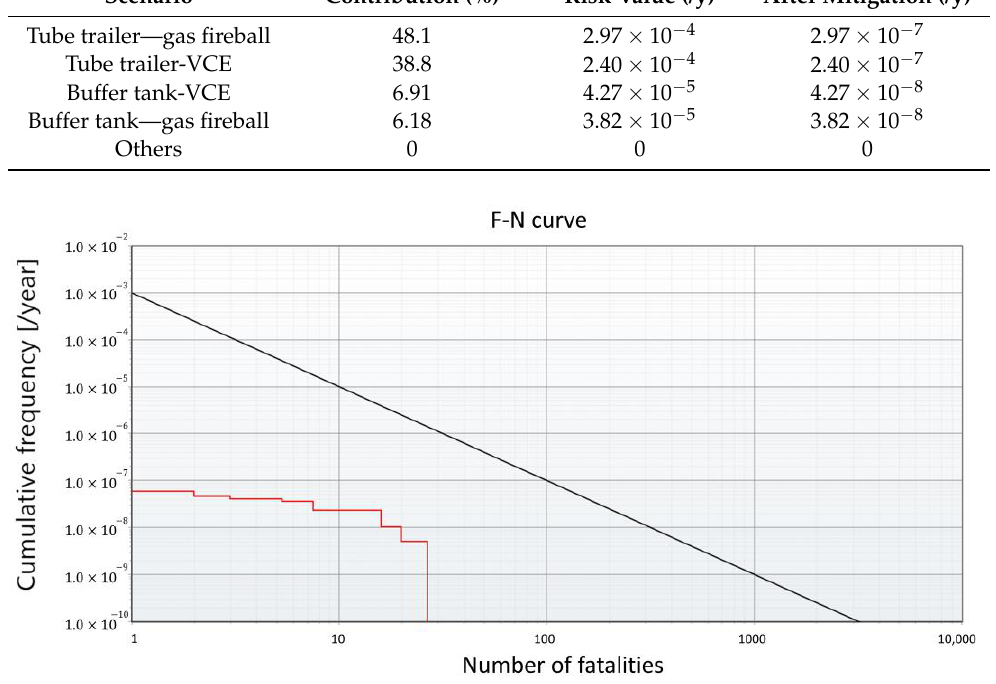
Figure 9. F-N curve of the GHRS system after applying the active safety systems. Table 6. The risk values before and after applying safety mitigation measures with respect to the scenarios for the GHRS system.